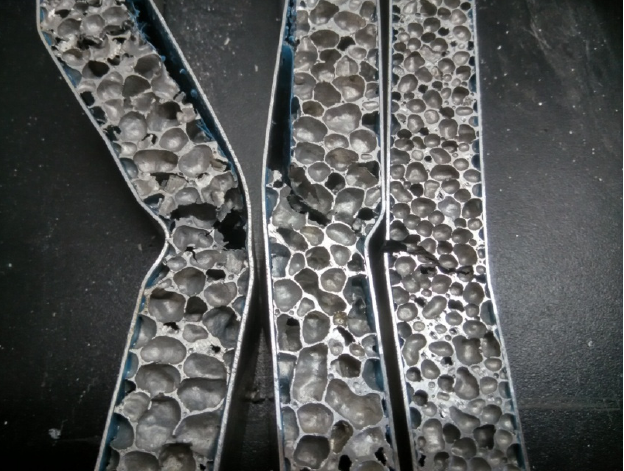
Figure 6. Fatigue fracture morphology of three aluminum foam sandwich samples with different core densities (from left to right, ρ = 0.3, 0.4, 0.6 g/cm 3